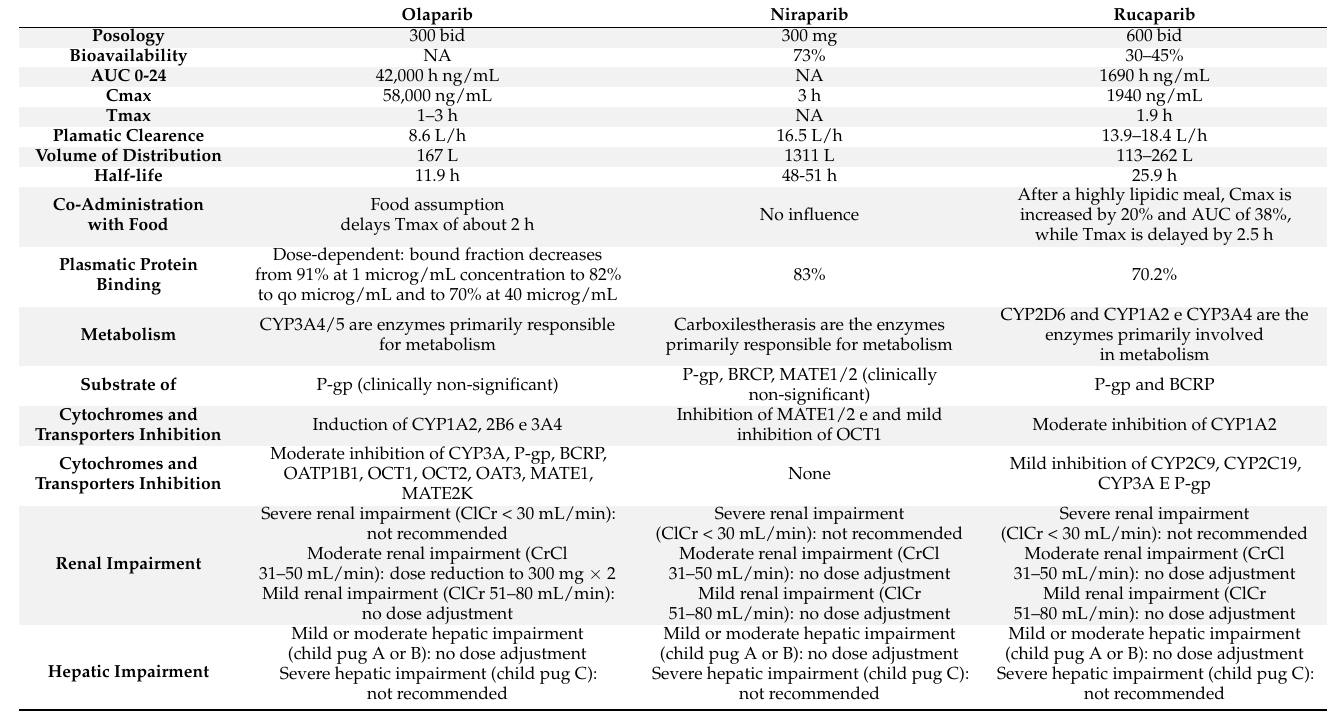
Table 2. Pharmacokinetic characteristics of PARP